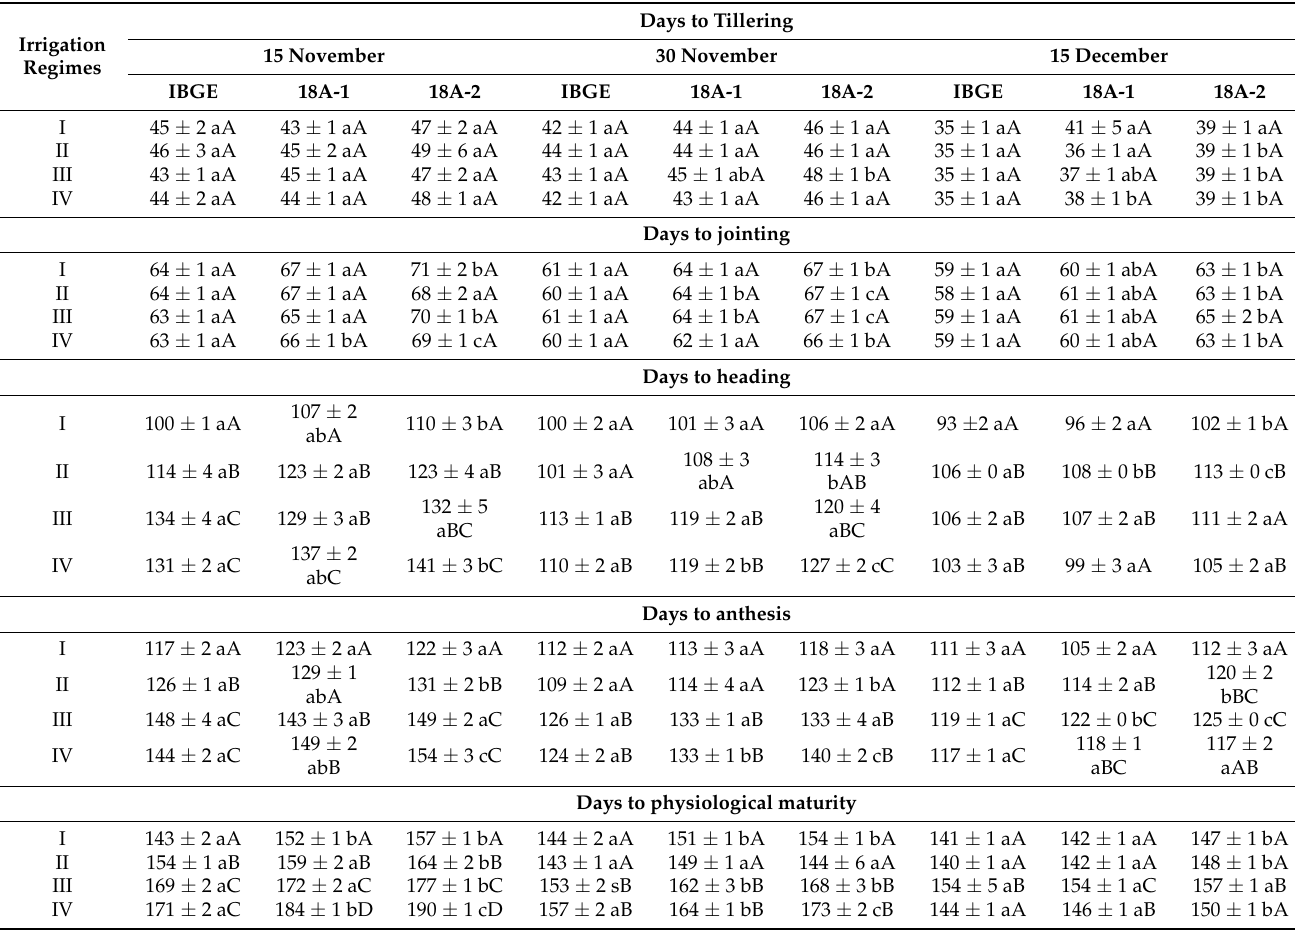
Values are means of six replicates from two growth cycles followed by standard errors of means ( n = 6). In a row under each parameter and showing dates, means with different lowercase letters show significant differences between wheat cultivars, and in each column, values with different uppercase letters show significant differences between irrigation regimes at p < 0.05. I—irrigation at tillering stage; II—irrigations at tillering and booting stages; III—irrigations at tillering, booting, and flowering stages; IV—irrigations at tillering, booting, flowering, and grain filling